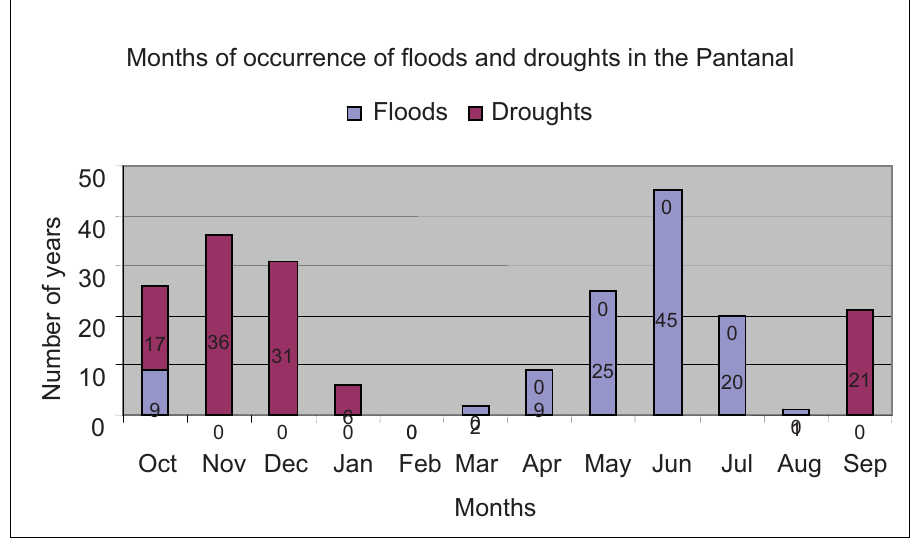
Figure 5. Months of occurrence of peaks of floods and